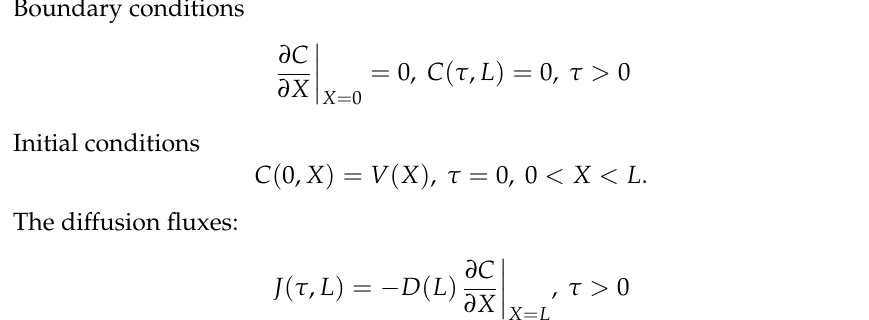
Figure 1. Drug release from a multi-laminated drug-controlled release device.